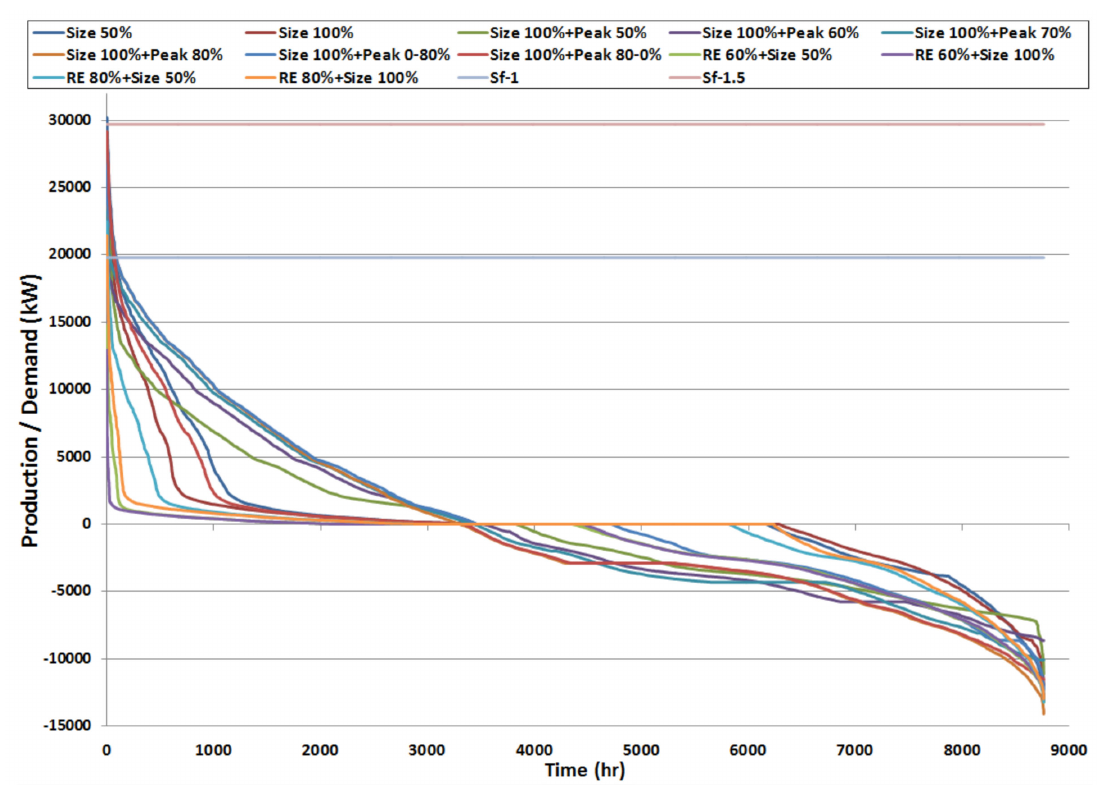
Figure A11. Main yearly results from the lowered RE production scenarios.